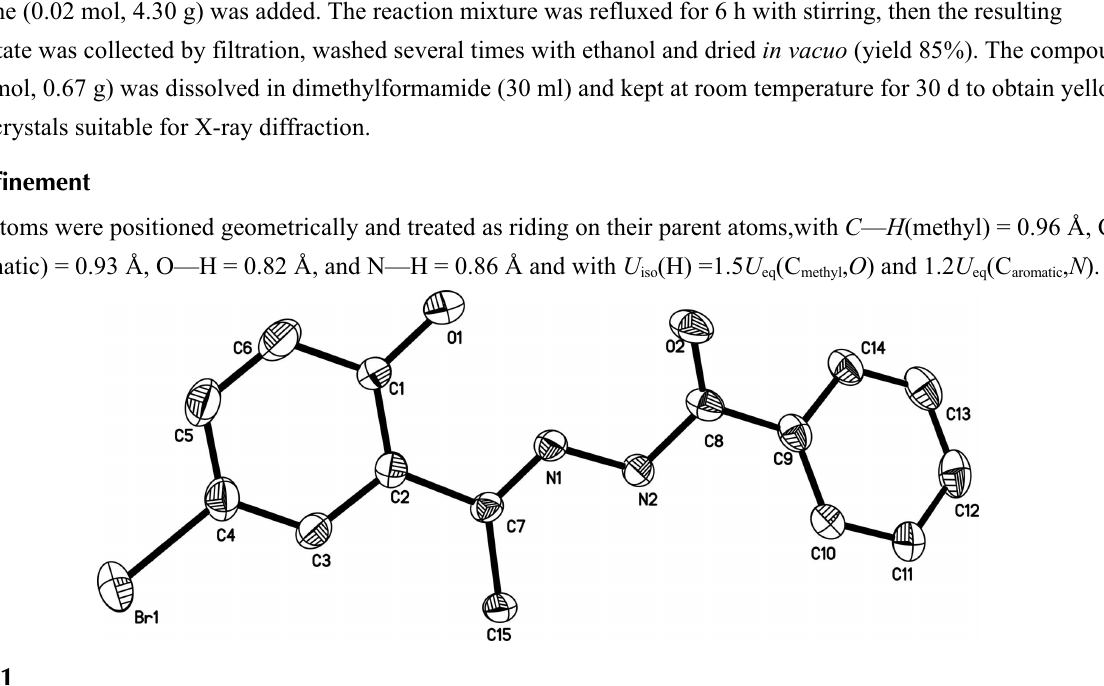
The molecular structure the title compound showing the atom-numbering scheme. Displacement ellipsoids are drawn at the 30% probability